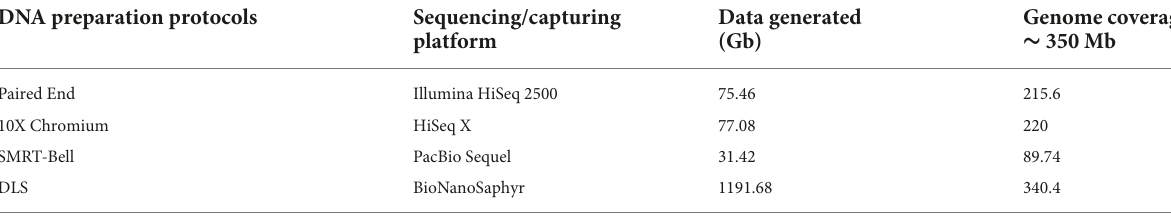
DNA preparation